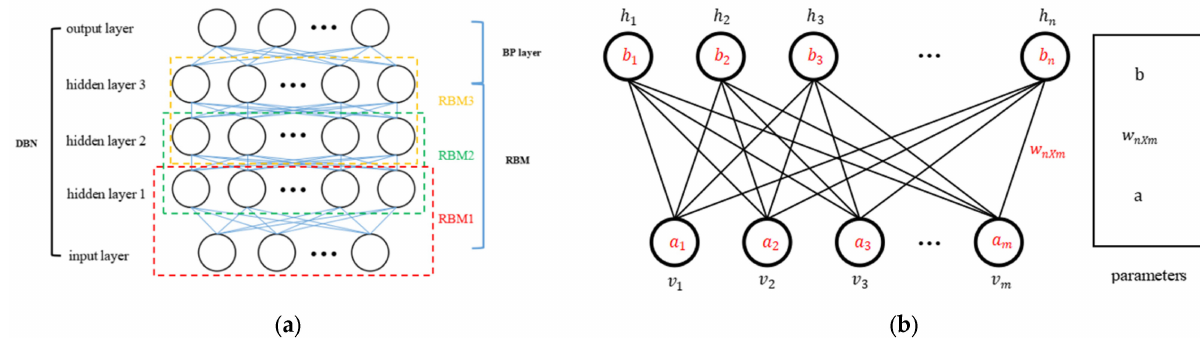
Figure 3. Structure of the DBN model ( a ) and RBM ( b ).